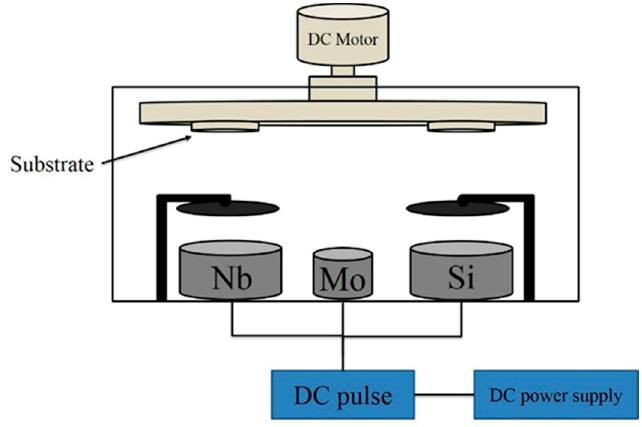
Figure 6. Schematic diagram of the DC magnetron sputtering system.